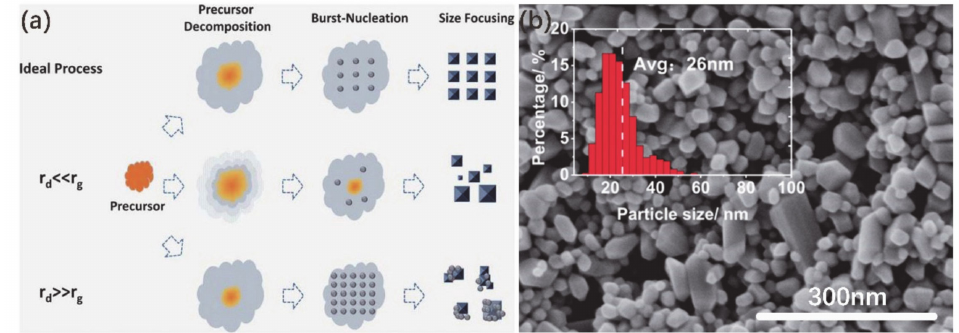
Figure 3. ( a ) The schematic illustration of growth of VO 2 nanoparticles (NPs) under the ideal “heating-up” process and under the situations of r d (cid:28) r g and r d (cid:29) r g . ( b ) SEM image of grown VO 2 (M) NPs; the inset in ( b ) shows the size distribution profile from more than 300 particles. Reproduced from [50], with the permission from Royal Society of Chemistry,